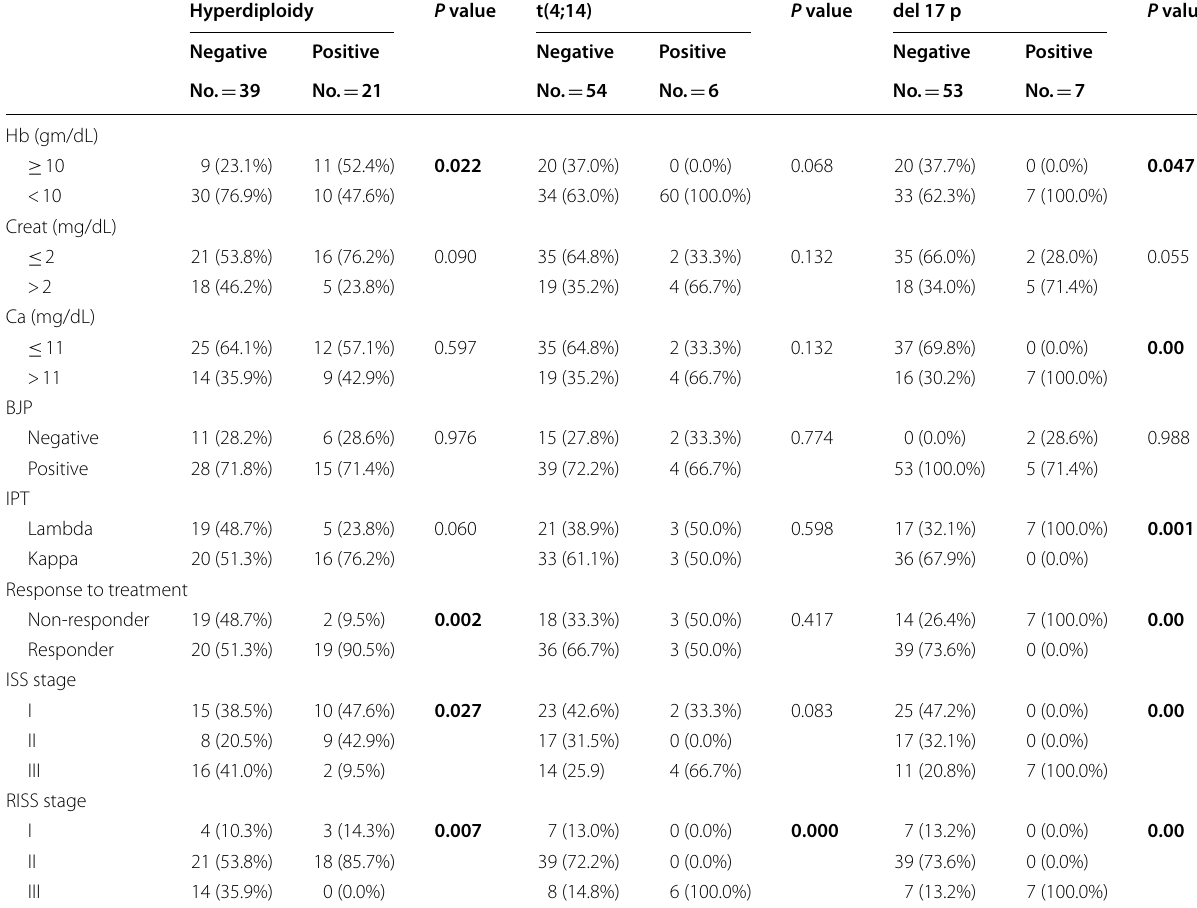
Table 1 Comparison of cytogenetic aberrations and the studied clinical parameters in our